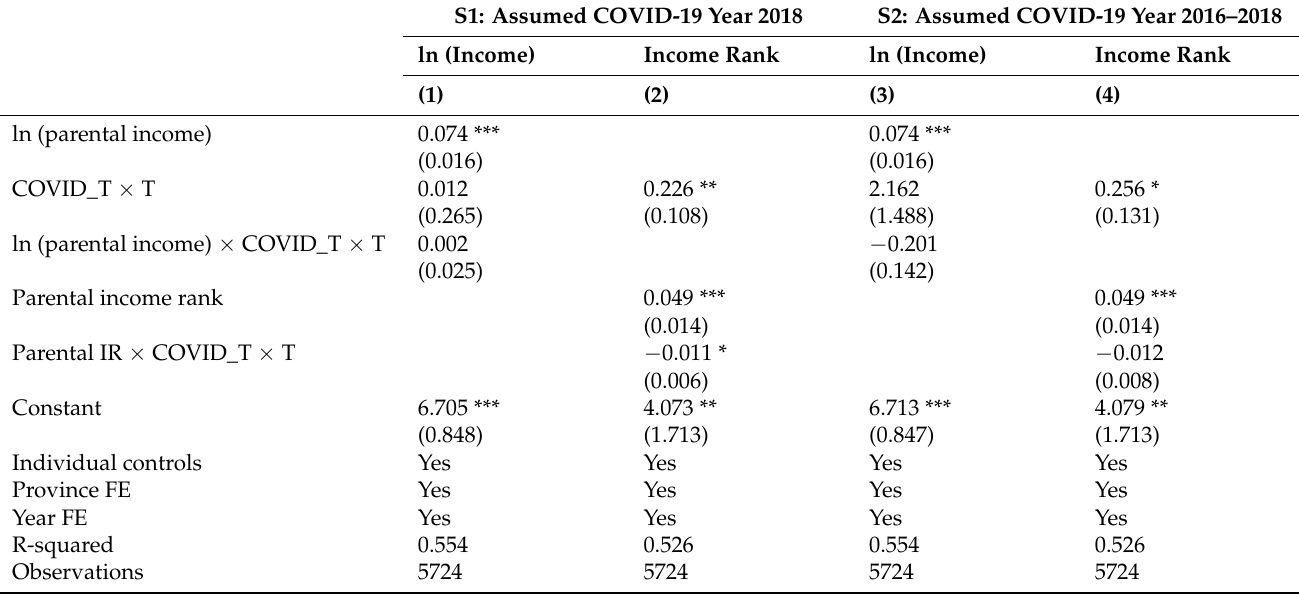
Table A4. Placebo tests using the total COVID-19 pandemic intensity index.